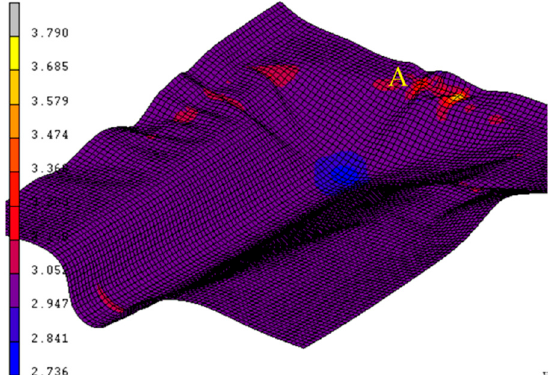
Figure 10. Thickness distribution of the drawing in the preforming process by the optimized design.